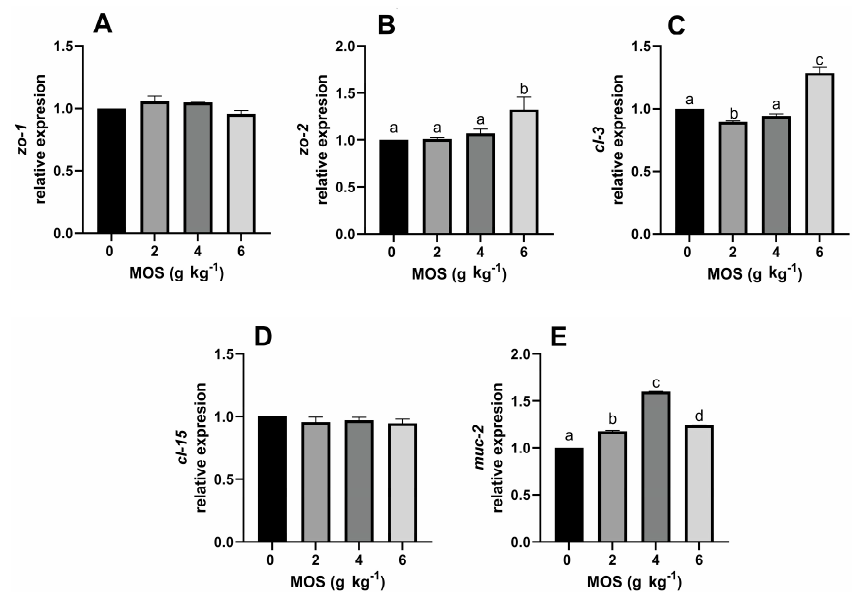
Figure 3. Effect of dietary mannan-oligosaccharides on the relative expression of genes involved in the intestinal barrier of A . tropicus larvae. ( A ) zo-1 ; ( B ) zo-2 ; ( C ) cl-3 ; ( D ) cl-15 ; ( E ) muc-2 . Letters above bars indicate differences between groups ( p > 0.05).